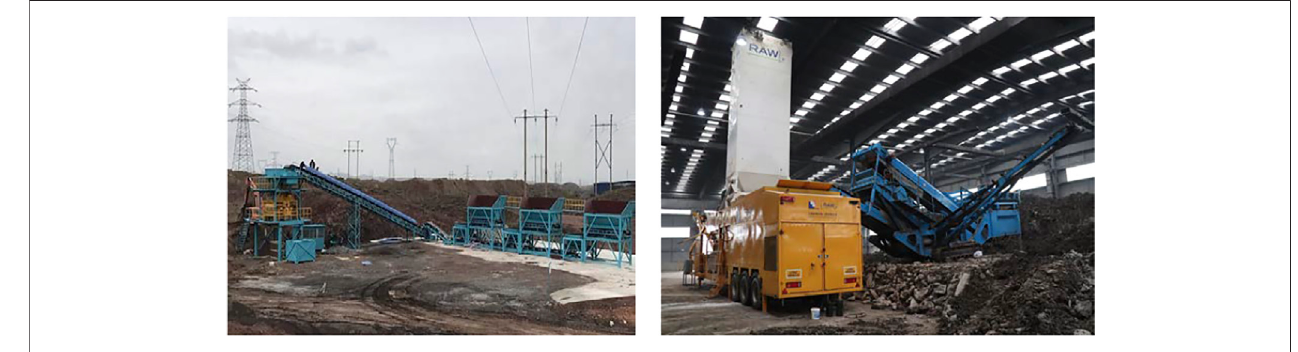
FIGURE 3 | Contaminated soil remediation equipment.